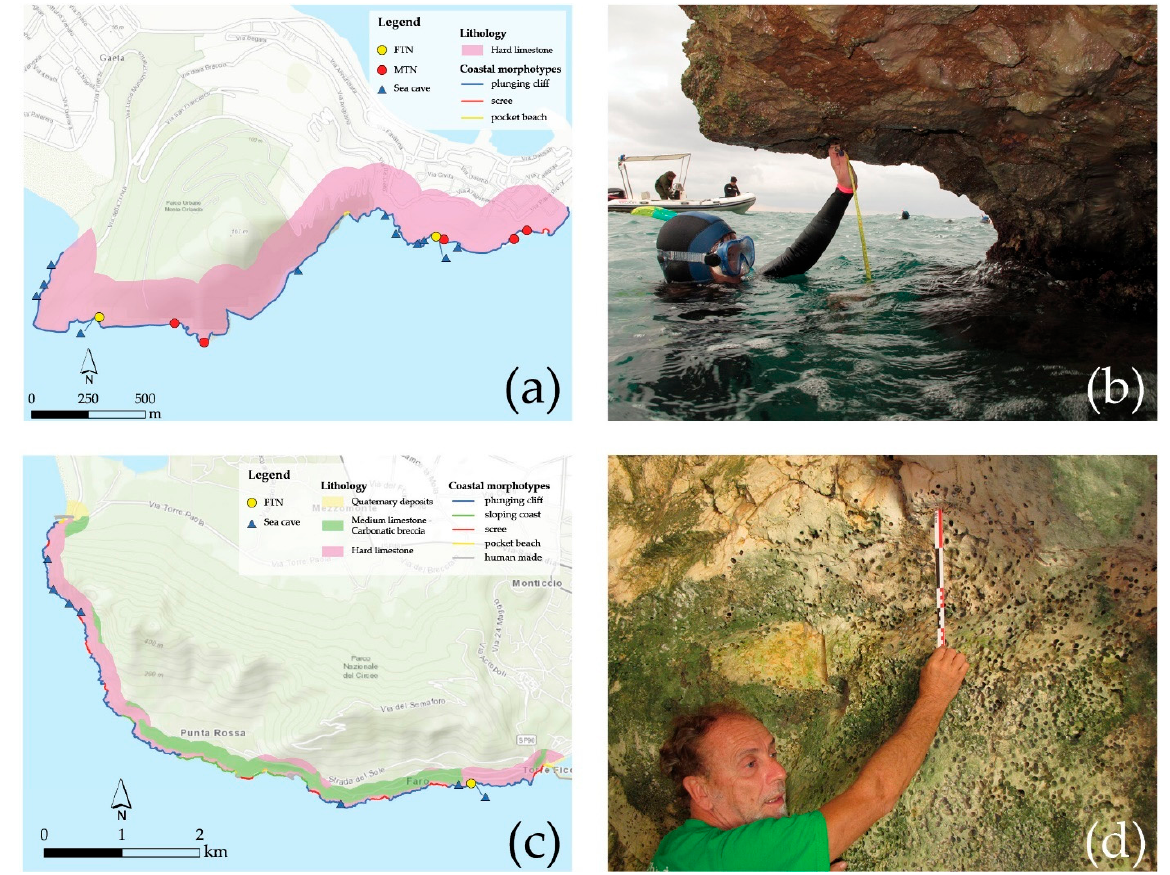
Figure 6. ( a ) Maps of coastal morphotypes and surveyed geomorphological structures at Monte Orlando (Gaeta), ( b ) MTN at Monte Orlando (Gaeta), ( c ) maps of the surveyed geomorphological structures at Circeo promontory, and ( d ) Lithophaga lithophaga holes inside the FTN at Grotta delle Capre (Circeo promontory).